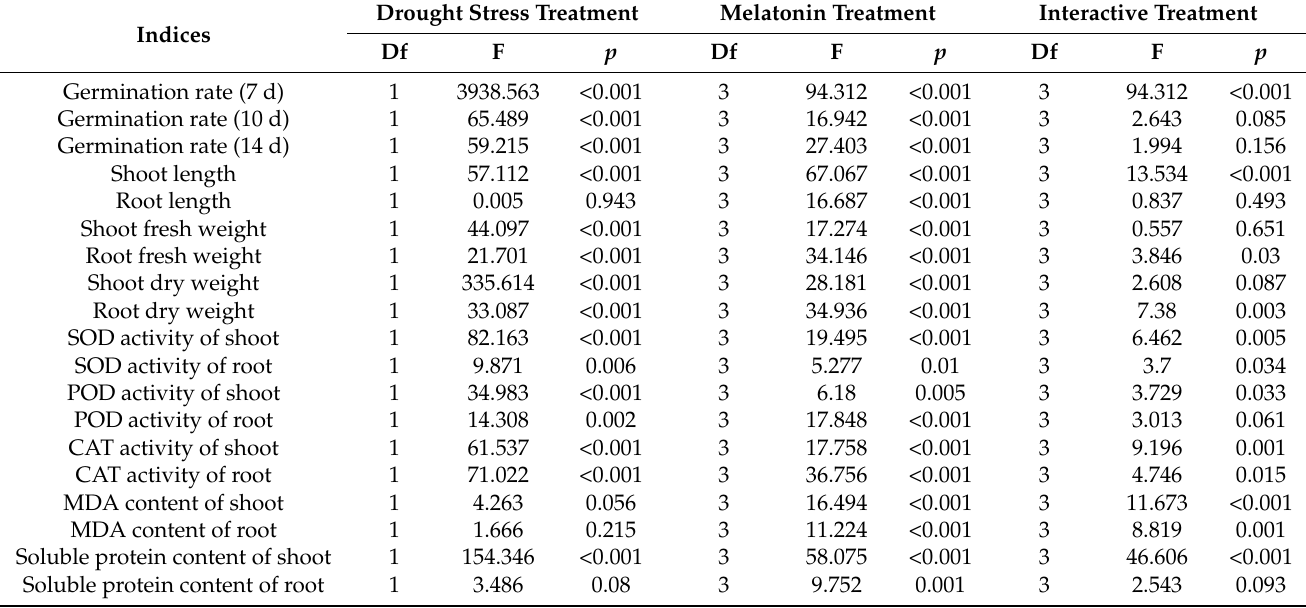
Table 2. Two-factor analysis of variance for the effects of drought stress and exogenous melatonin concentration on rice seed germination and physiological